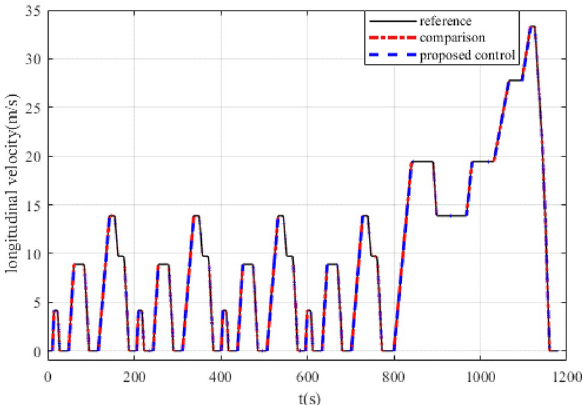
Figure 9 Simulation results of longitudinal velocity